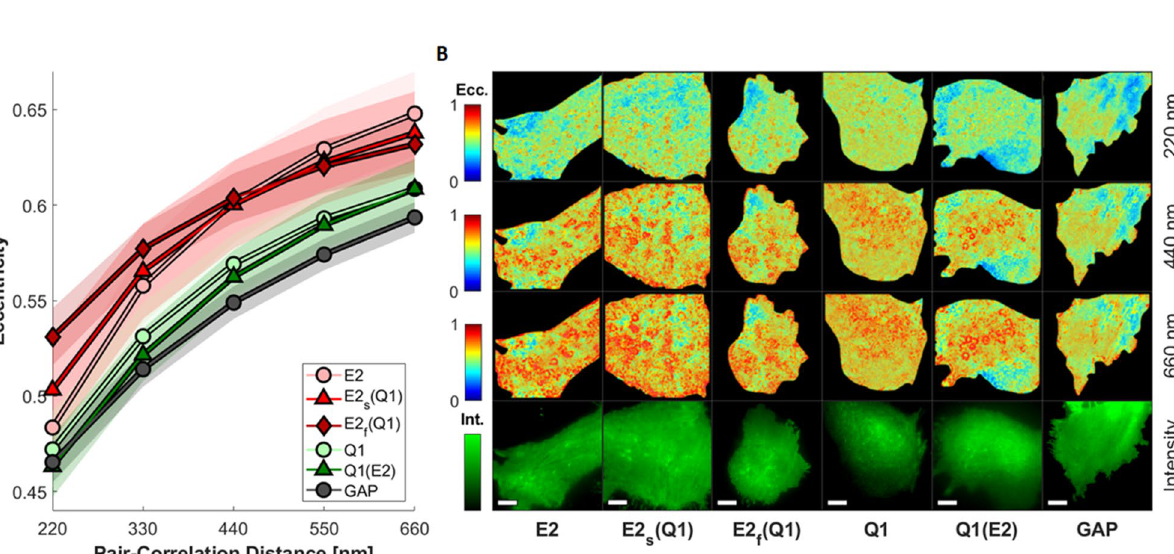
standard deviation. ±